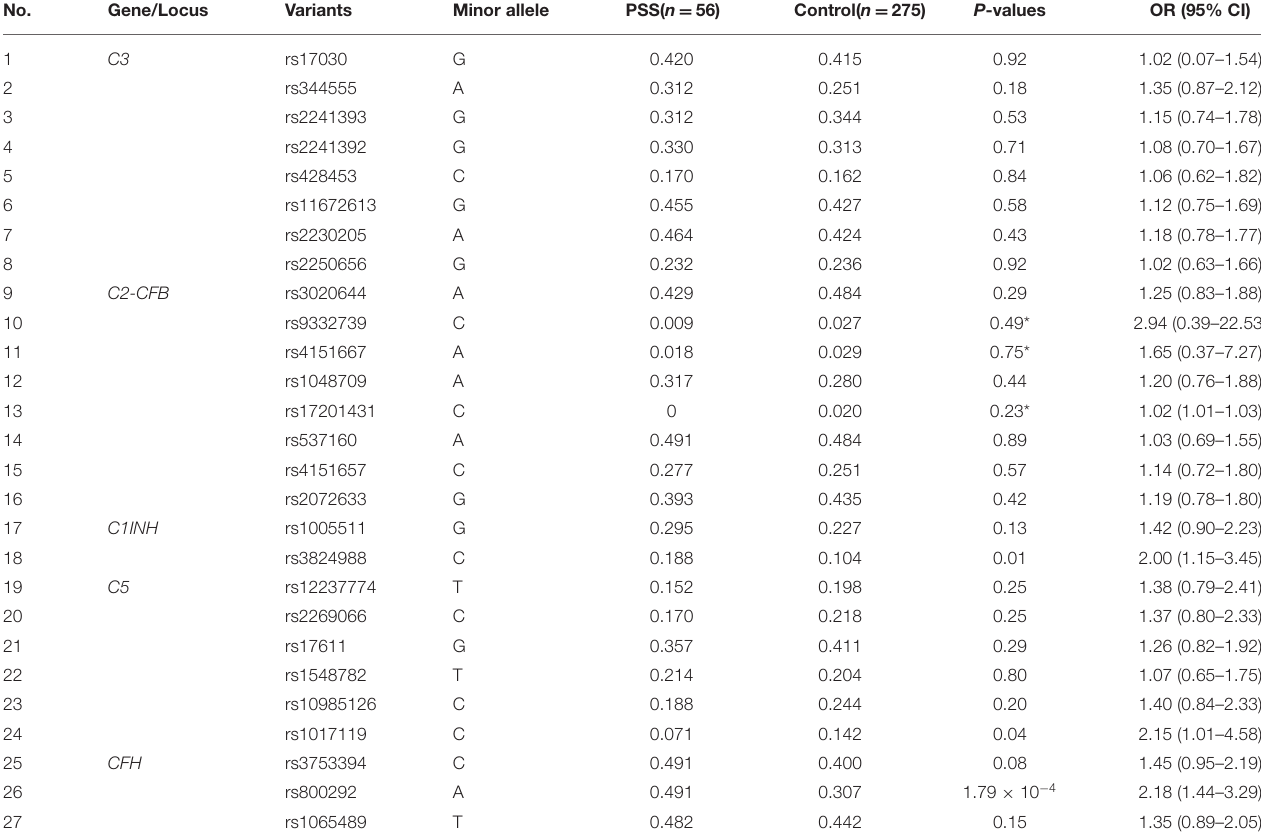
TABLE 2 | Allelic association of genetic variants with PSS.